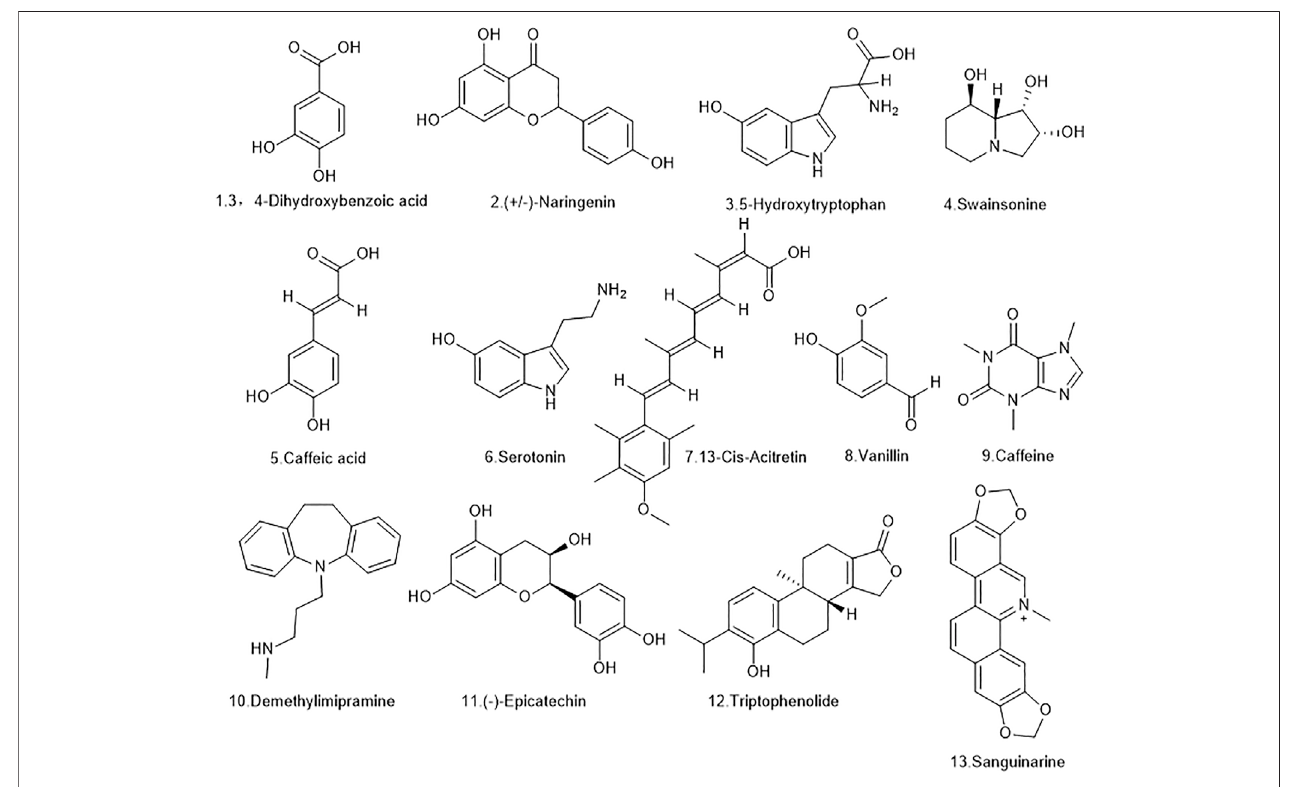
FIGURE 2 | The molecular formulas of the 13 bioactive components identi fi ed from D. of fi cinale extract.